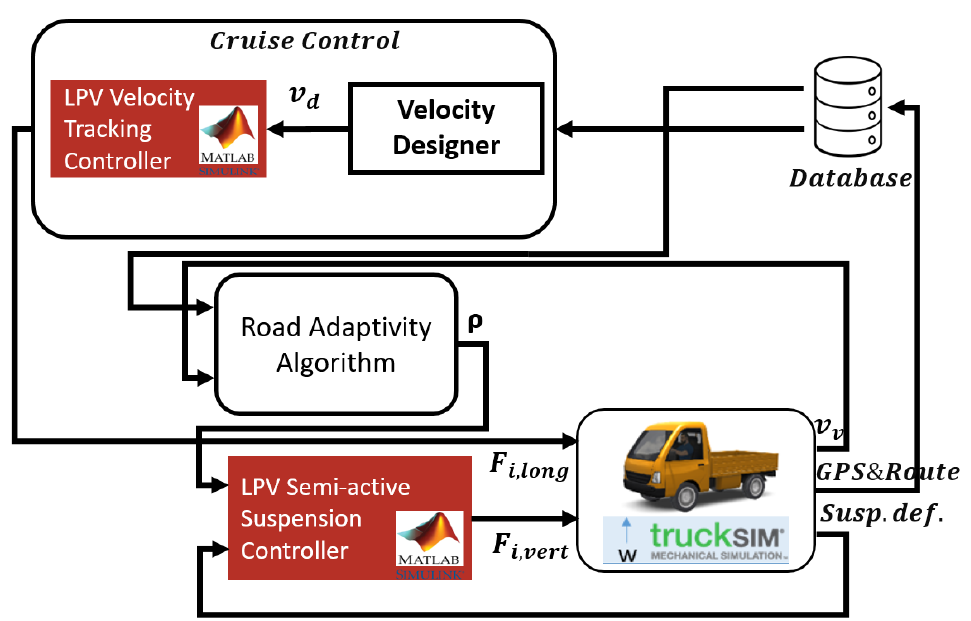
Figure 8. System